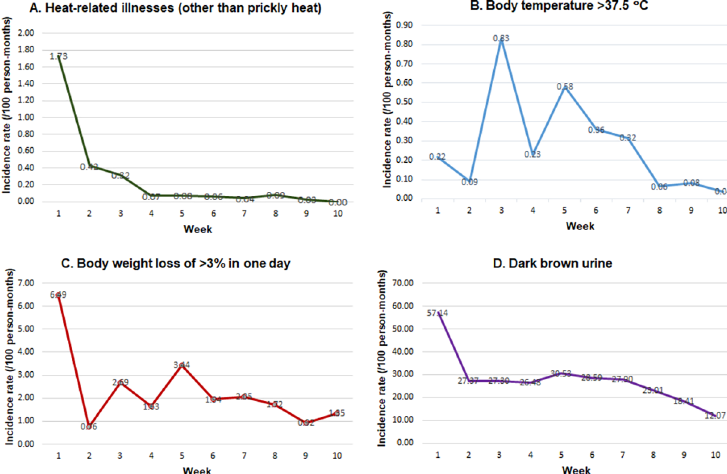
Fig 1. Incidence rates per 100 person-months of heat-related outcomes by week of basic